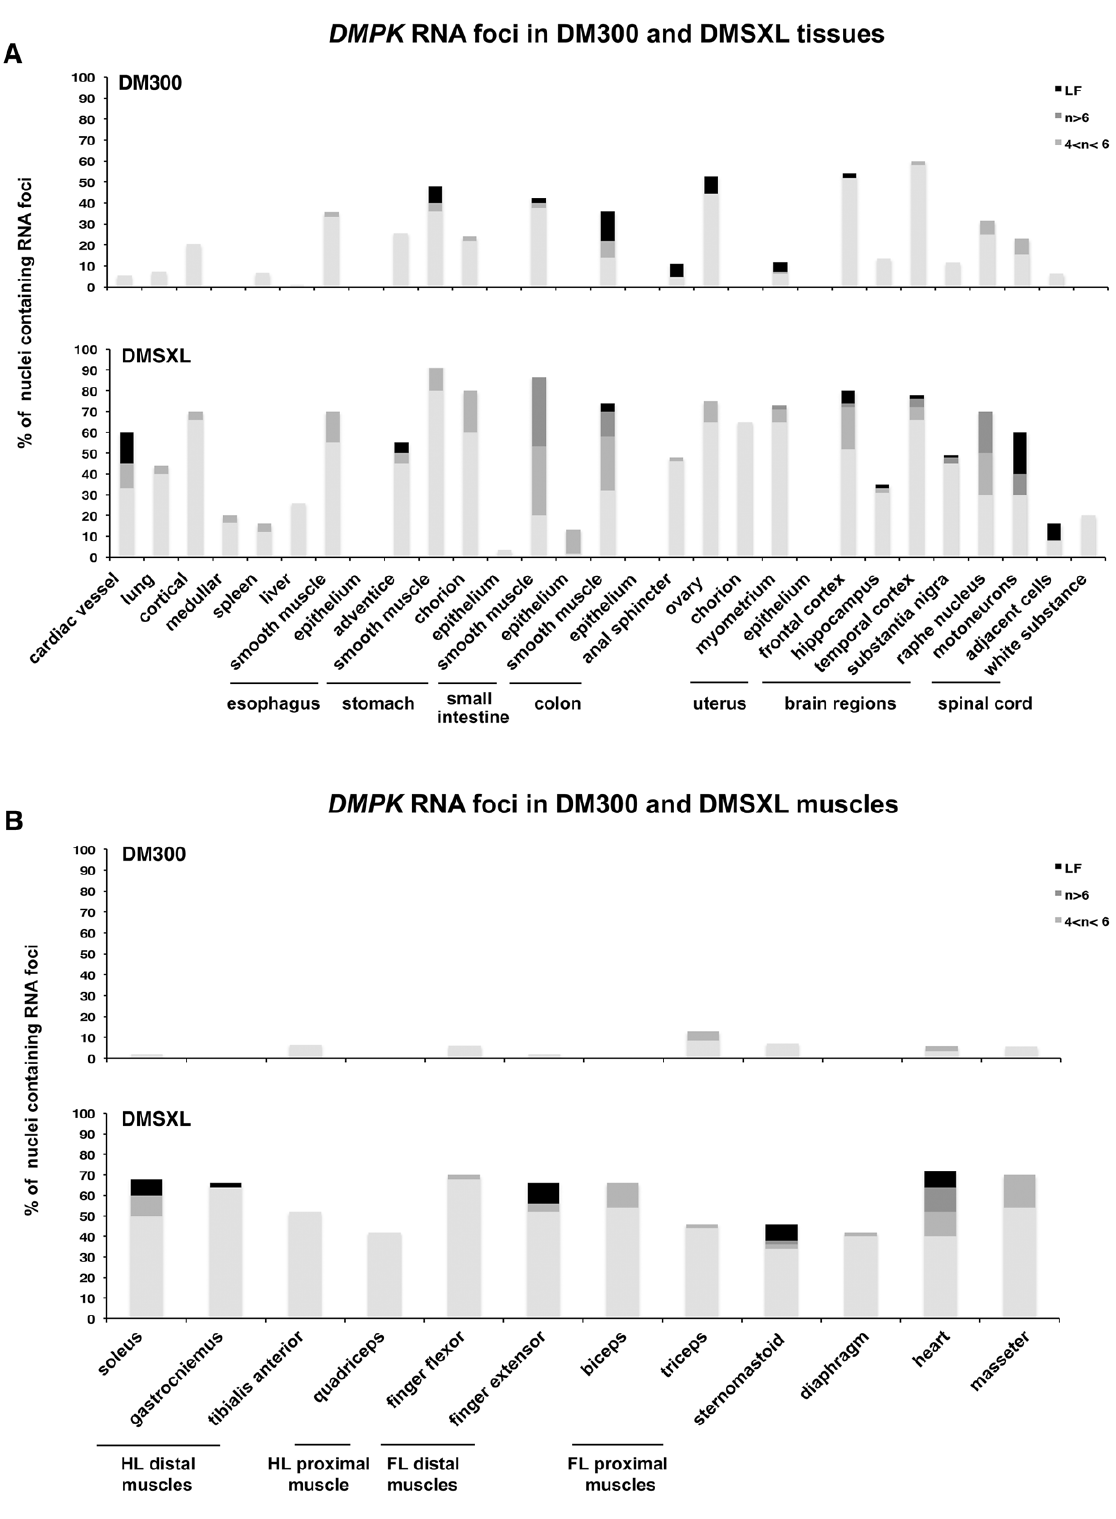
Figure 4. Foci distribution in mice carrying CTG expansions. The distribution and quantification of DMPK RNA foci in various tissues (A) and muscles (B) were compared in 8 month-old homozygous mice with 500/600 CTG (DM300) or 1000/1400 CTG (DMSXL). HL, hind leg; FL foreleg. n is for the number of foci per nucleus. LF: large foci.